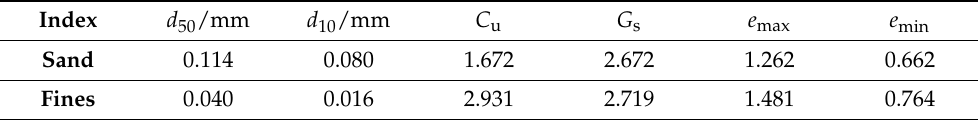
Table 1. The basic physical properties of the sand and fines.